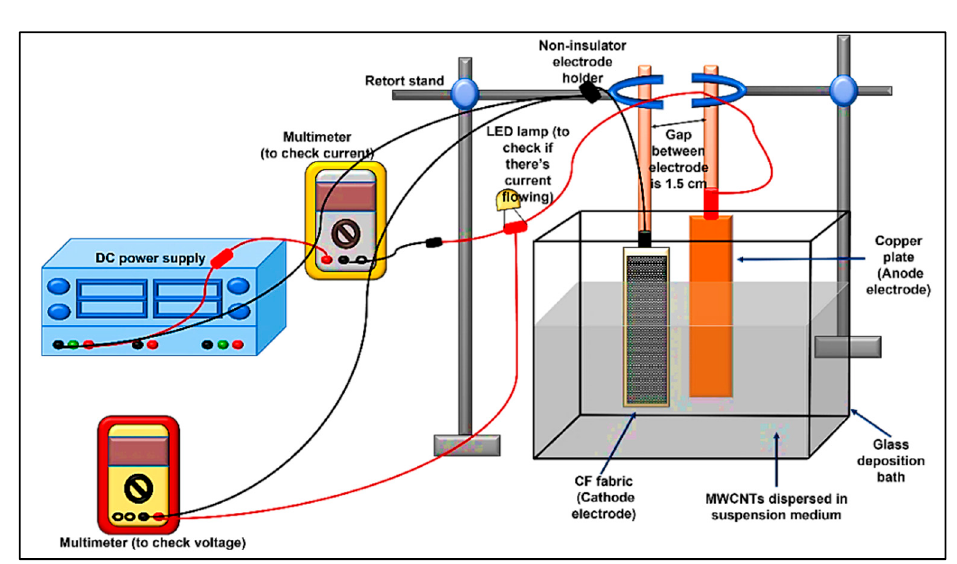
Figure 1. Schematic diagram of the EPD process for the fabrication of hybrid MWCNT–CF materi- als.